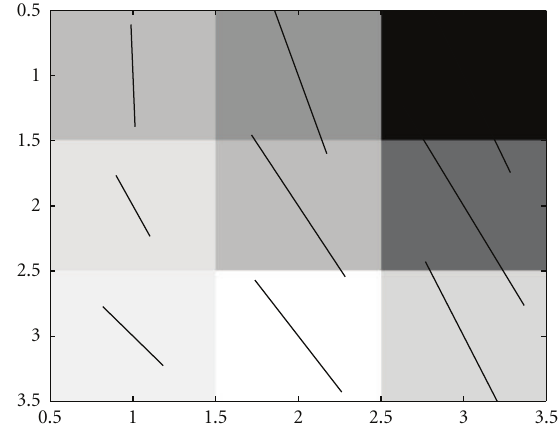
Figure 5: A sample of a 3 × 3 neighbourhood of pixels with the orientation field of candidate pixels overlaid with black lines.